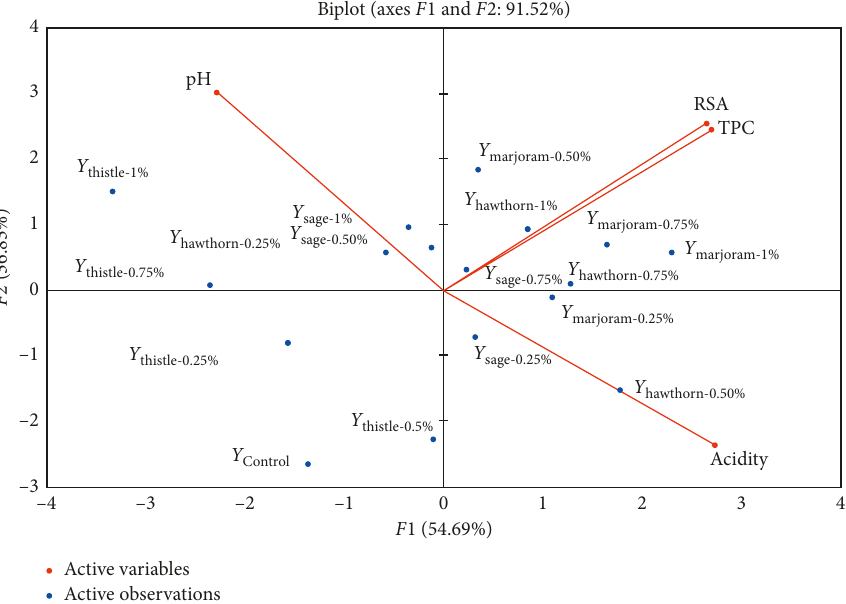
Figure 9: PCA loadings of the yogurt characteristics after 1 day of storage.